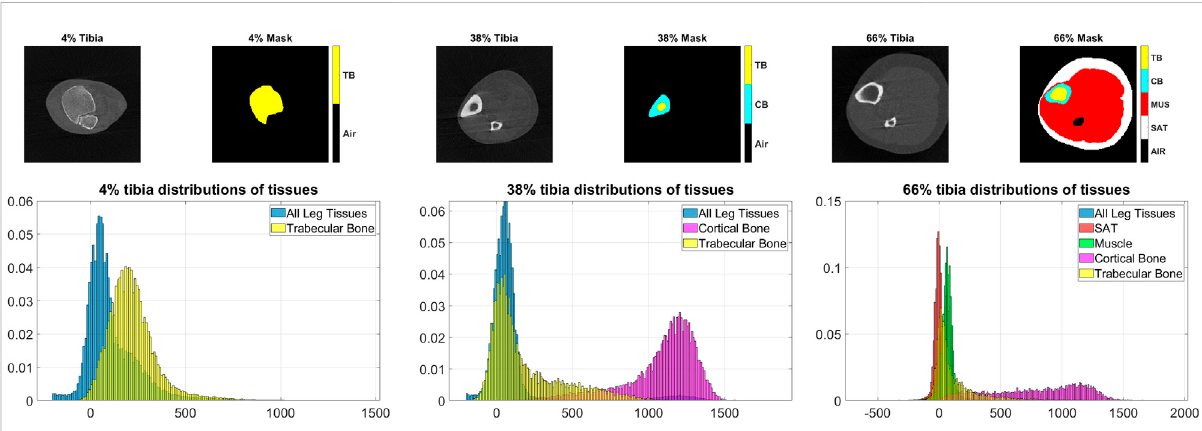
FIGURE 8 Examples of the pQCT scans, masks and tissue distributions. Top row: image-mask pairs of pQCT scans at 4%, 38%, and 66% tibial length respectively. Bottom: distributions of tissues corresponding to the above tibia sites. On the masks, air, trabecular bone, cortical bone, muscle, and subcutaneous adipose tissue (SAT) are identi fi ed by black, yellow, cyan, red, and white colors,